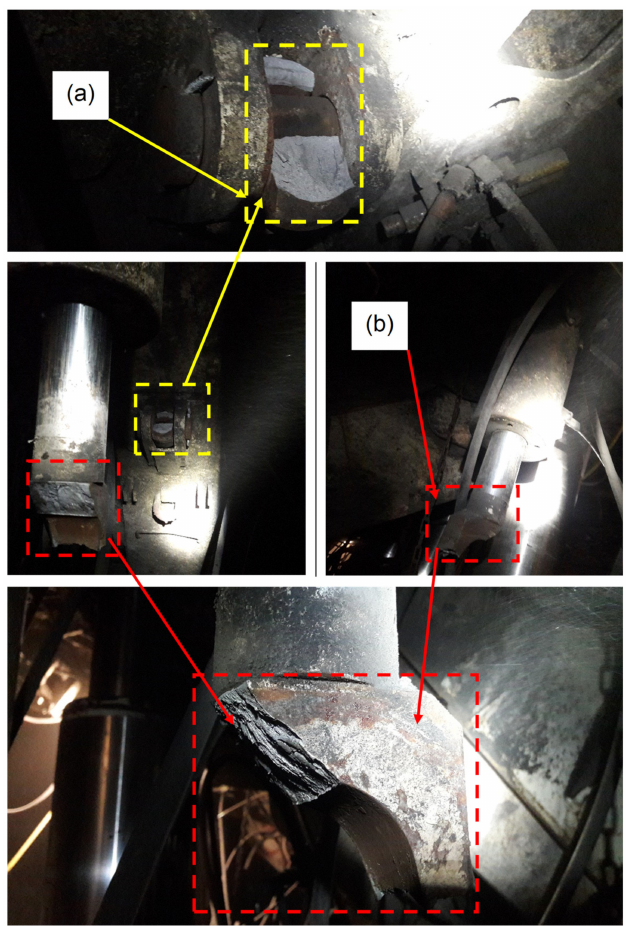
Figure 3. View of the resulting damage to the canopy support actuator in the longwall: (a) a fragment of a broken bolt hole of the support actuator structure and (b) broken bolt hole of the support actuator.